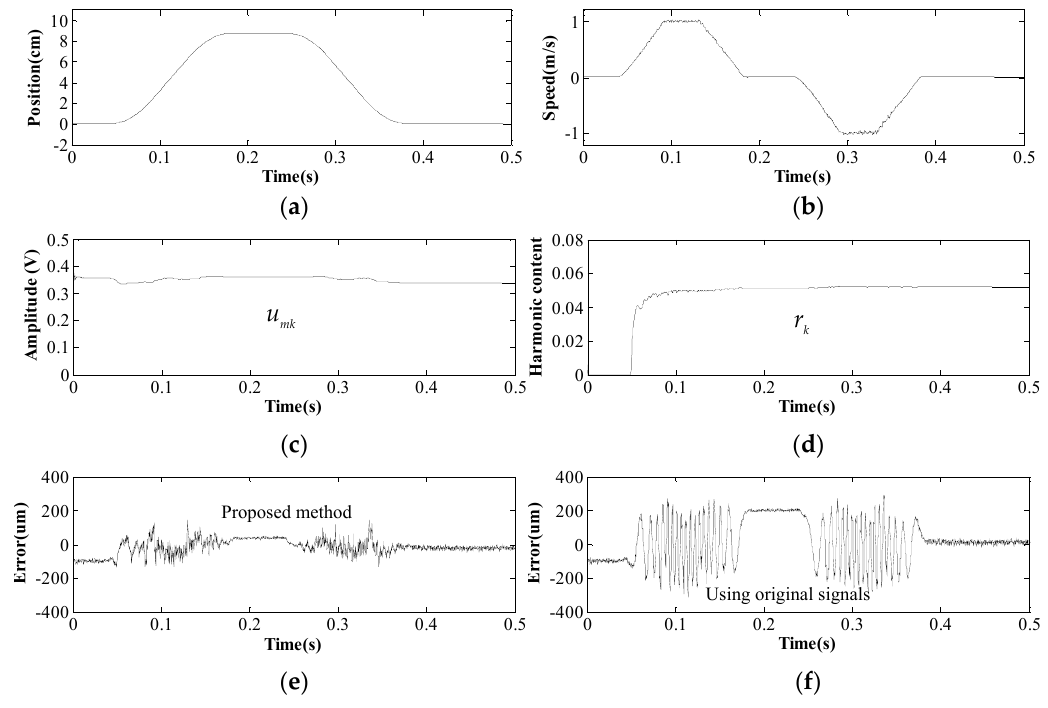
Figure 10. Position control of PMTLM using proposed position detection method. ( a ) Mover position of PMTLM; ( b ) Mover speed of PMTLM; ( c ) Convergence process of u mk ; ( d ) Convergence process of r k ; ( e ) Position detection error using proposed method; ( f ) Position estimation error using original sensor signals.